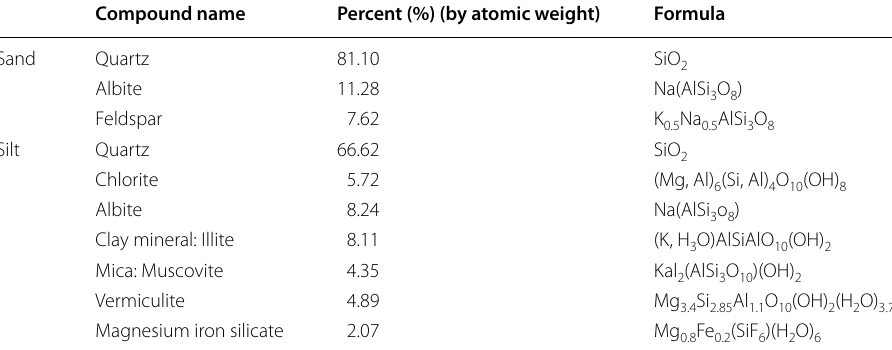
Table 2 Index properties of sand and silt used in the study Soil type Clean